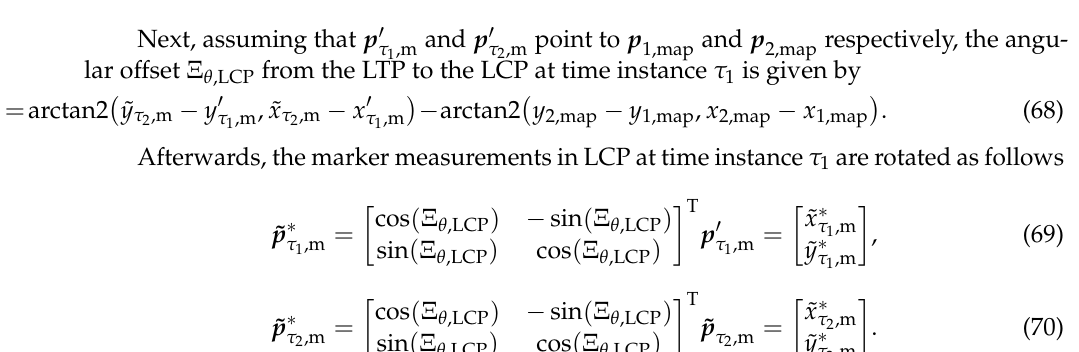
Figure 4. Shown is a graphical depiction of the geometry used for calculating the vehicle